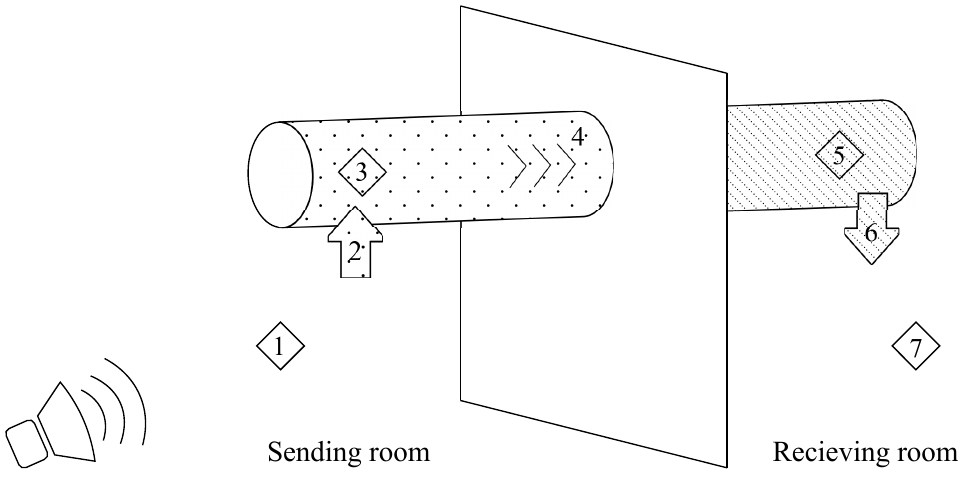
Figure 1. Illustration model of how sound travels from the sending room to the receiving room if only the surface area affects the sound